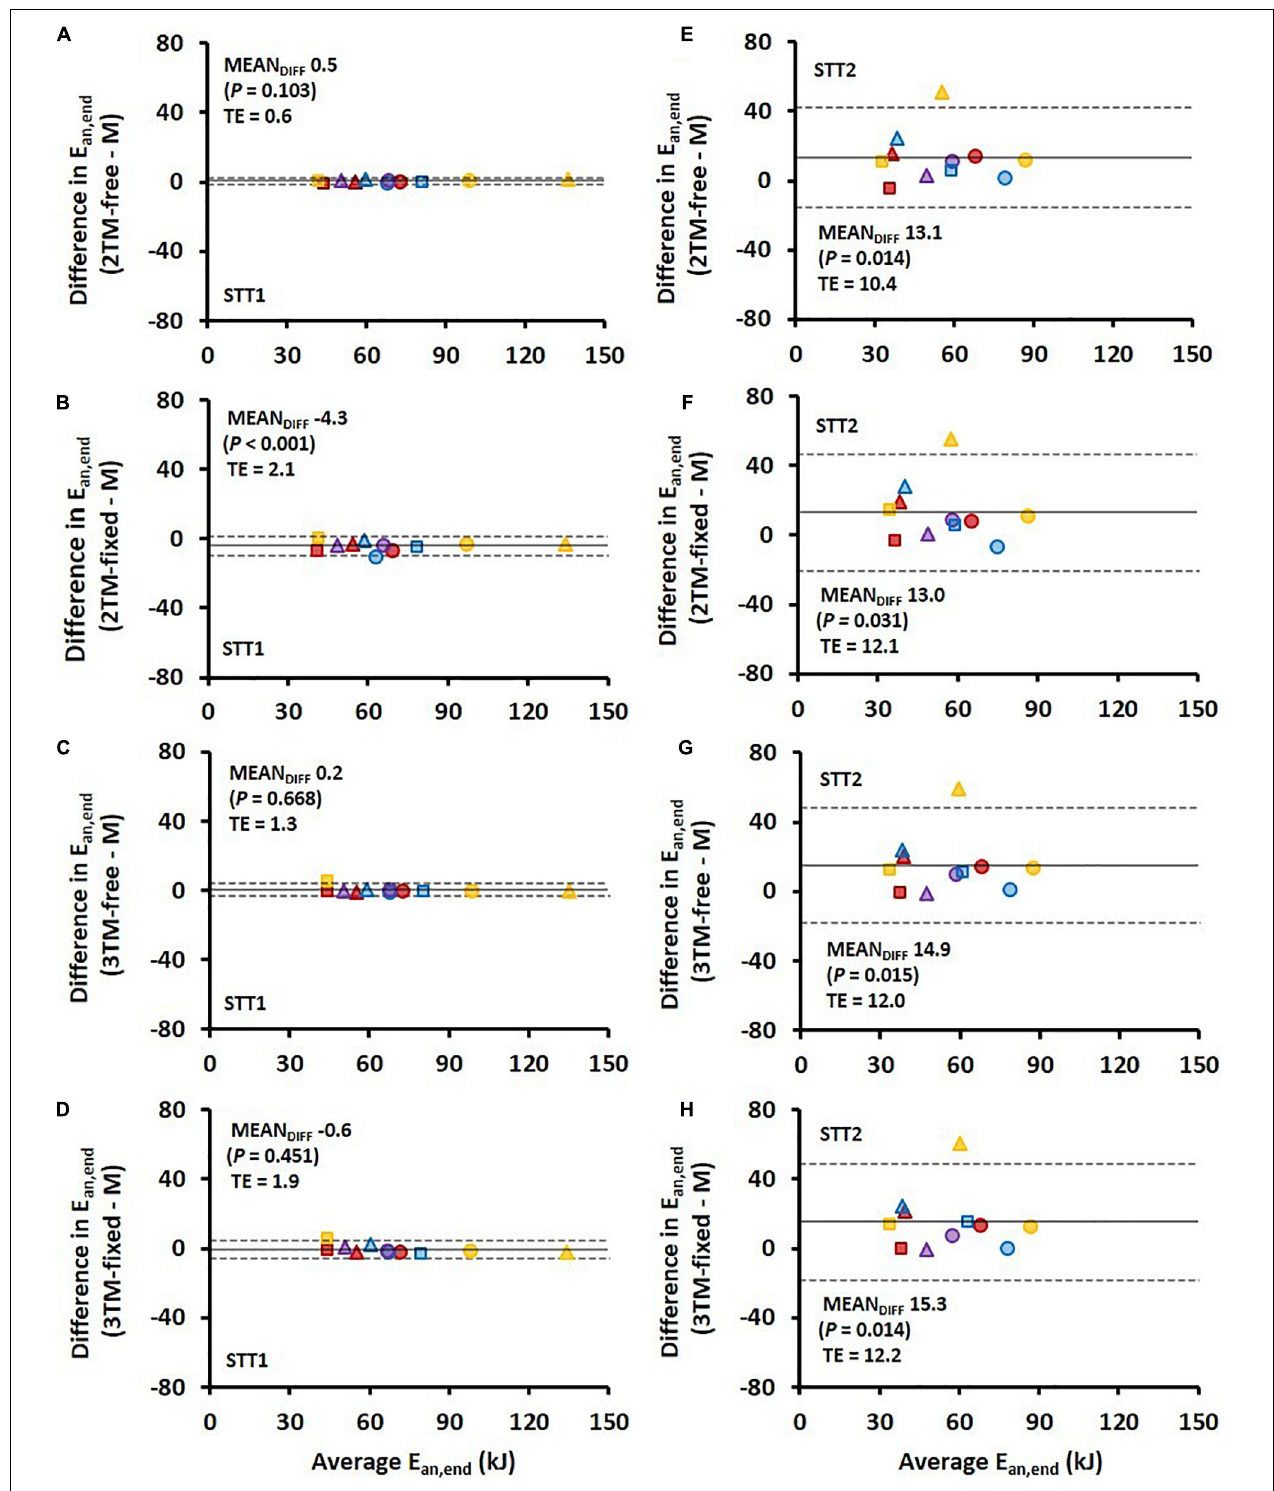
FIGURE 5 | Bland-Altman plots representing the mean difference (MEAN DIFF ) ± 95% limits of agreement (i.e., 1.96 SD) in the accumulated anaerobic energy contribution (E an , end ) associated with the first sprint time trial (STT1) presented in (A–D) and for the second sprint time trial (STT2) presented in (E–H) for the four various bioenergetic models vs. measurement data (M). TE, typical error.